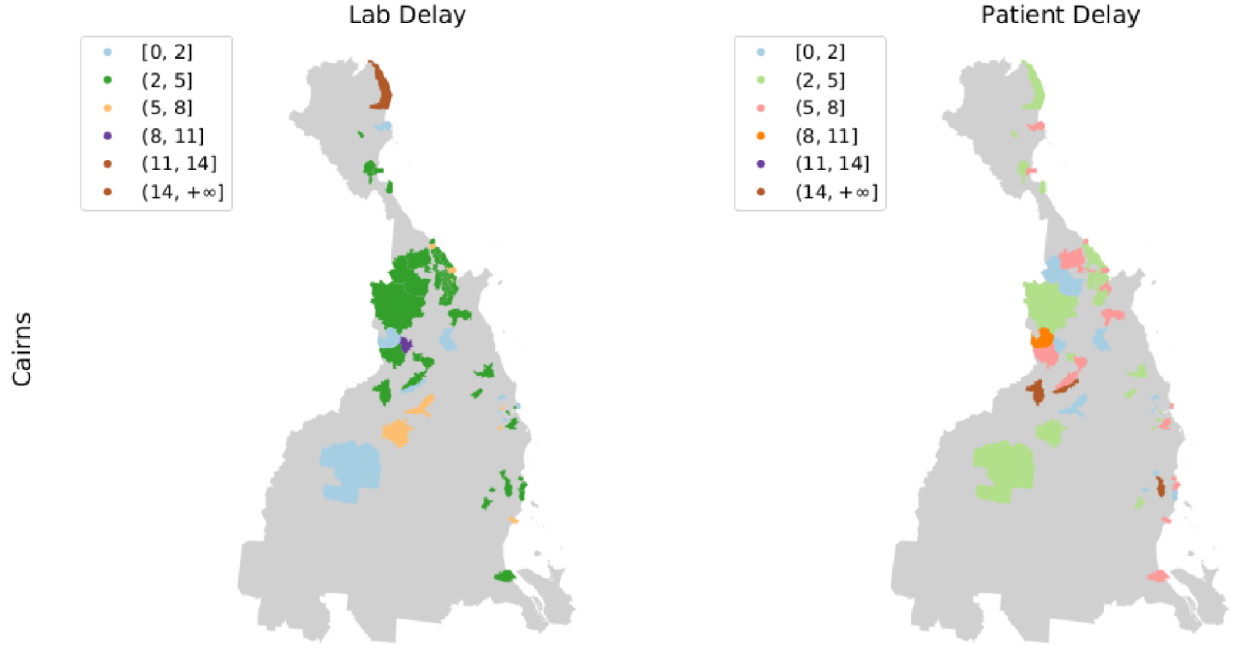
Fig 5. Spatial analysis of the notification delay components. Geo-spatial depiction of the average lab and patient delays in the localities of Cairns.